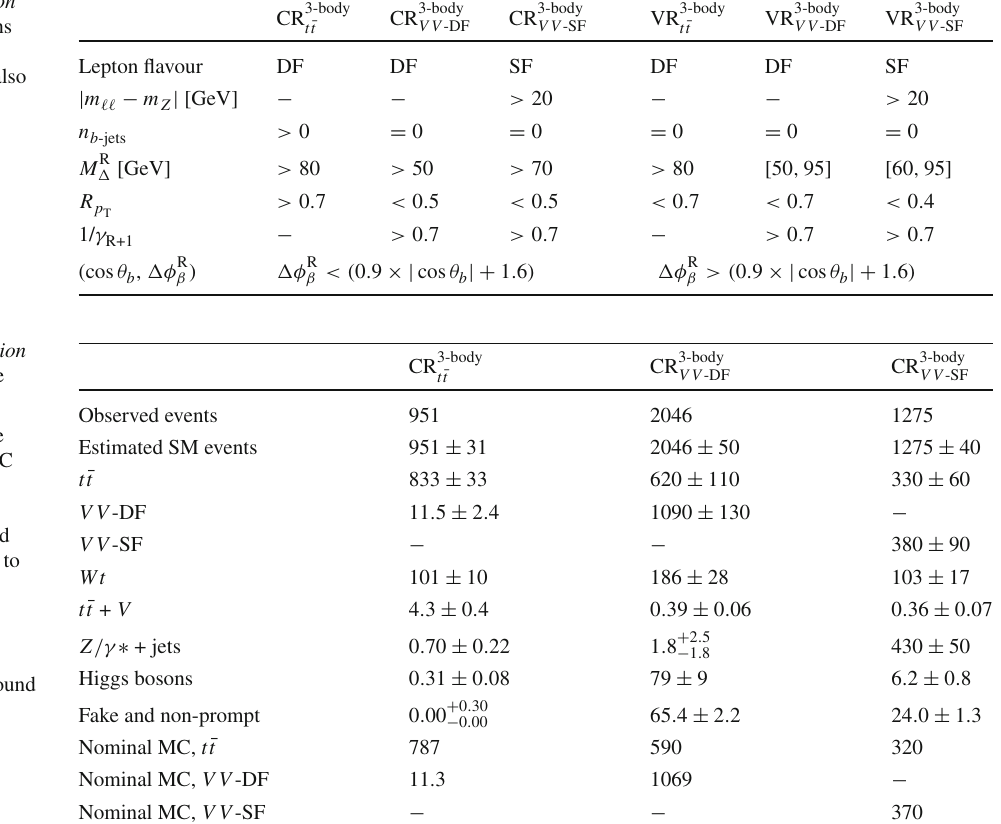
control and validation regions definitions. The common selection defined in Sect. 4 also applies to all regions